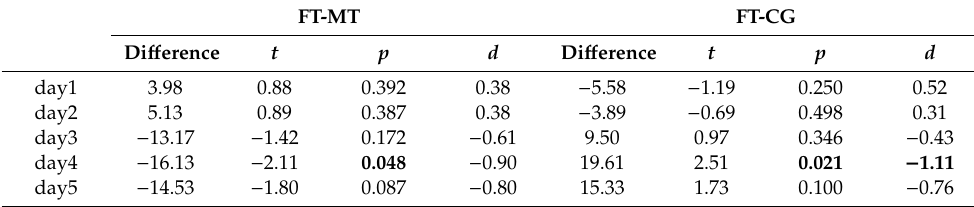
Table A8. Significance and e ff ect sizes for Deck D between the training groups.